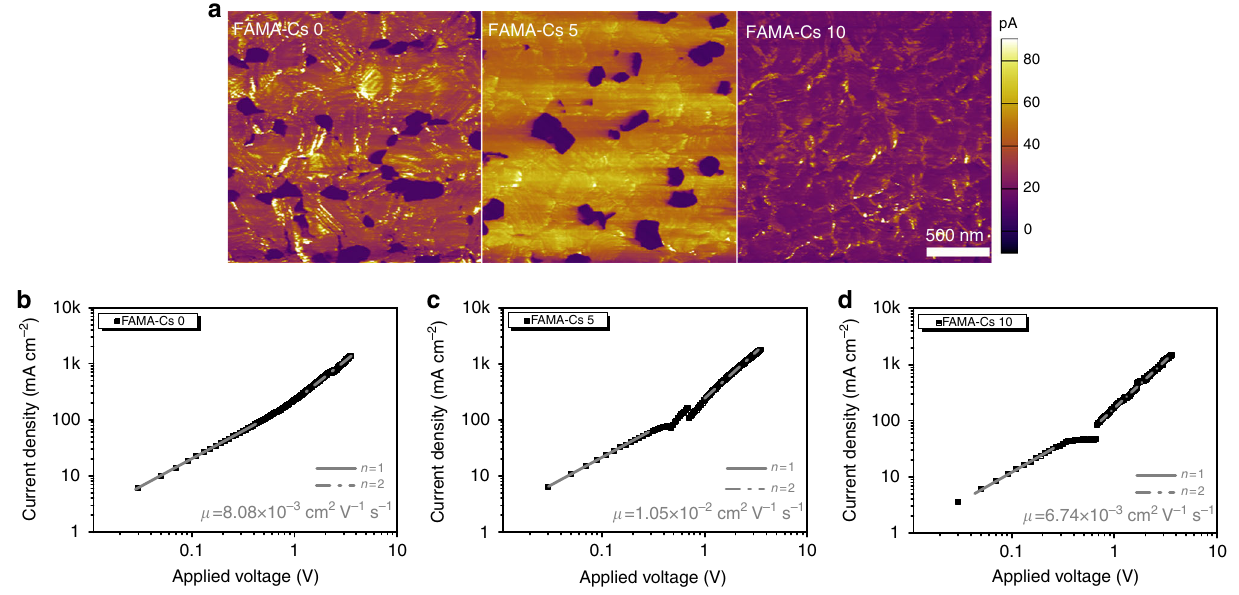
Fig. 5 c-AFM and SCLC analysis for cesium-doped samples. a c-AFM images and SCLC data for FAMA perovskite fi lms with different cesium-doping concentration (volume ratio: b 0, c 5 and, d